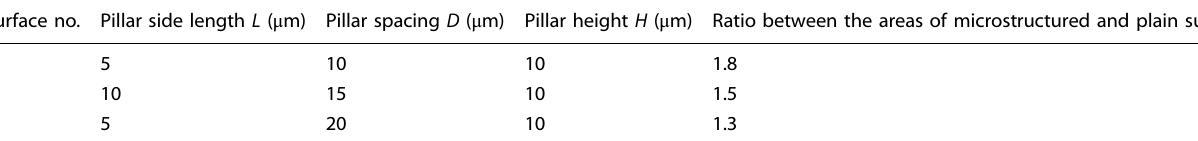
Table 1. Summary of micropillars geometrical properties.